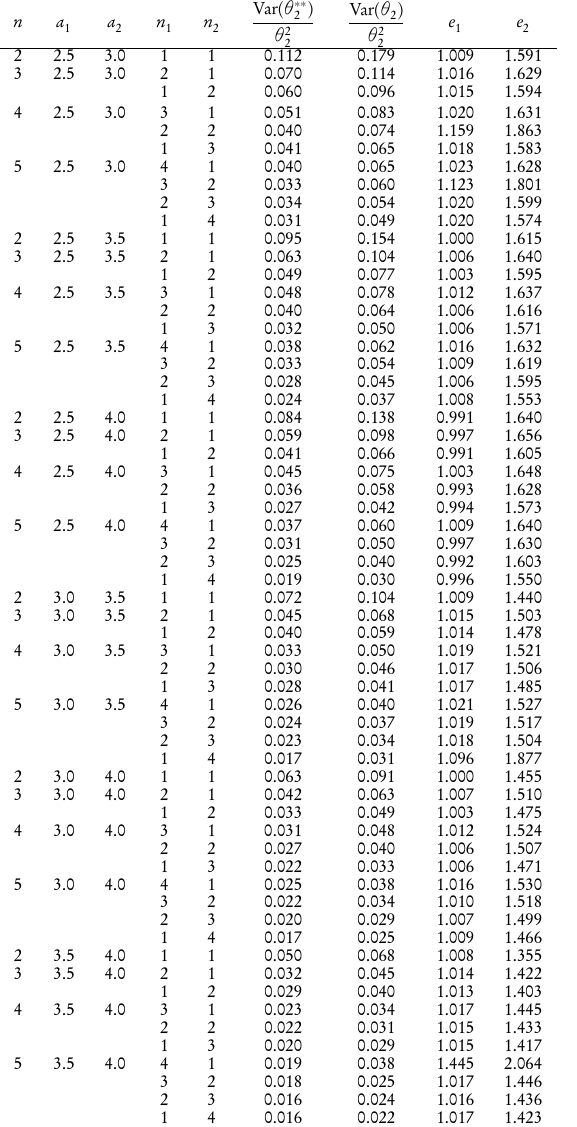
relative to ˆ θ and e of θ ∗∗ 2 2 2 + n and 2 ≤ n ≤ 5 1 2